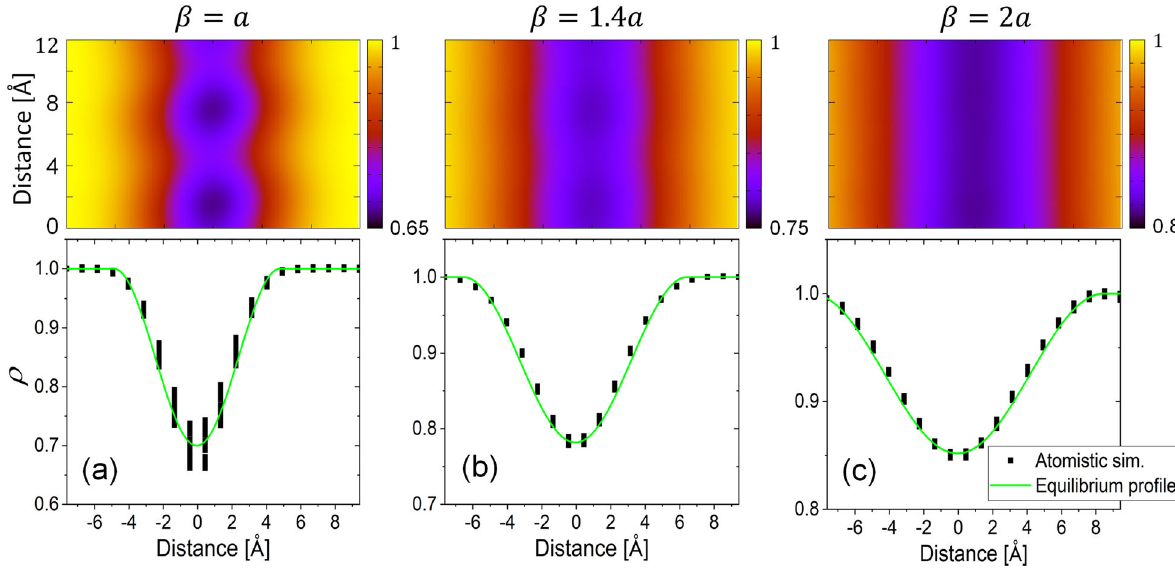
Fig. 1 Equilibrium density pro fi le across a GB in α -Fe. The results of atomistic simulations are shown and fi tted to the analytical solution shown in Eq. (8) (solid line). Three different smearing radii a β = a , b β = 1.4 a (atomistic cut-off radius), and c β = 2 a , with the interatomic distance a ~ 2.5 Å , were examined to compare the results. Further discussion on the coarse-graining idea is provided in the “ Methods ”